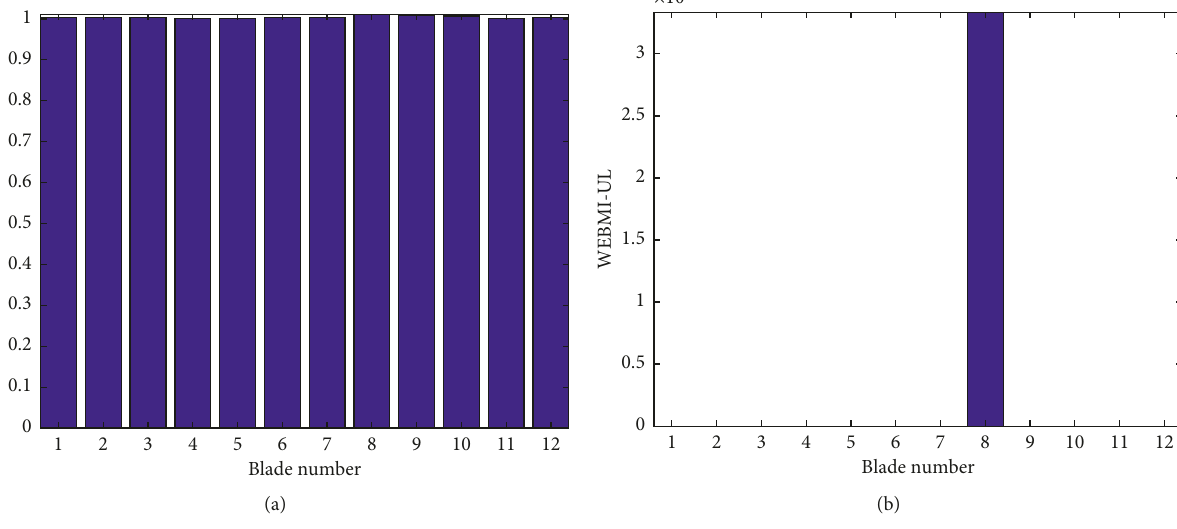
Figure 13: AECS results for the added mass located at blade 8. (a) WEBMI and (b) WEBMI-UL.